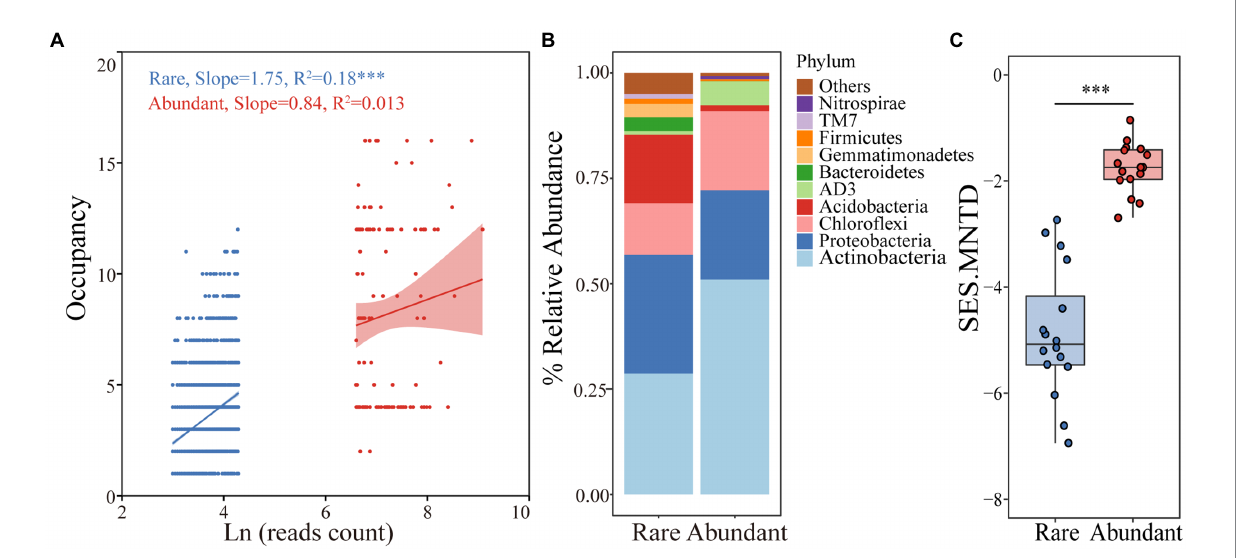
FIGURE 1 Distribution patterns of rare and abundant taxa in woodland soils. (A) Relationships between abundance and occupancy of rare and abundant ASVs. (B) Distributions of rare and abundant bacteria at the phylum level. (C) Comparison of the differences in SES.MNTD values between rare and abundant bacteria.